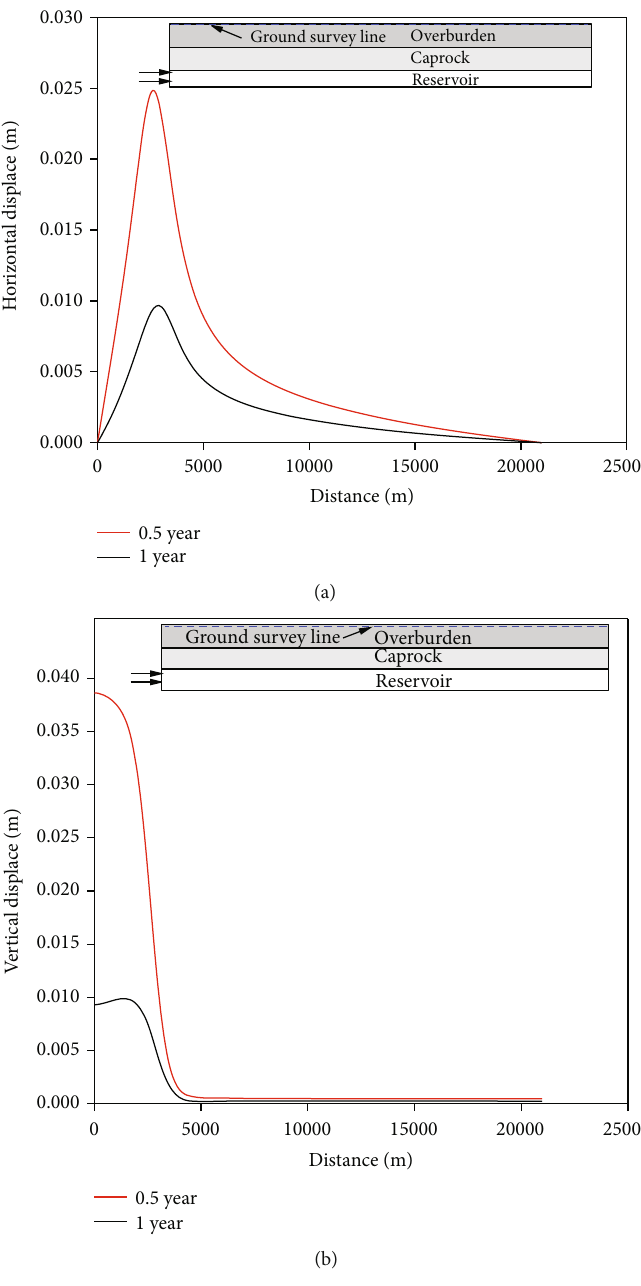
Figure 17: Displacement curve of ground surface survey line. (a) Horizontal displace. (b) Vertical